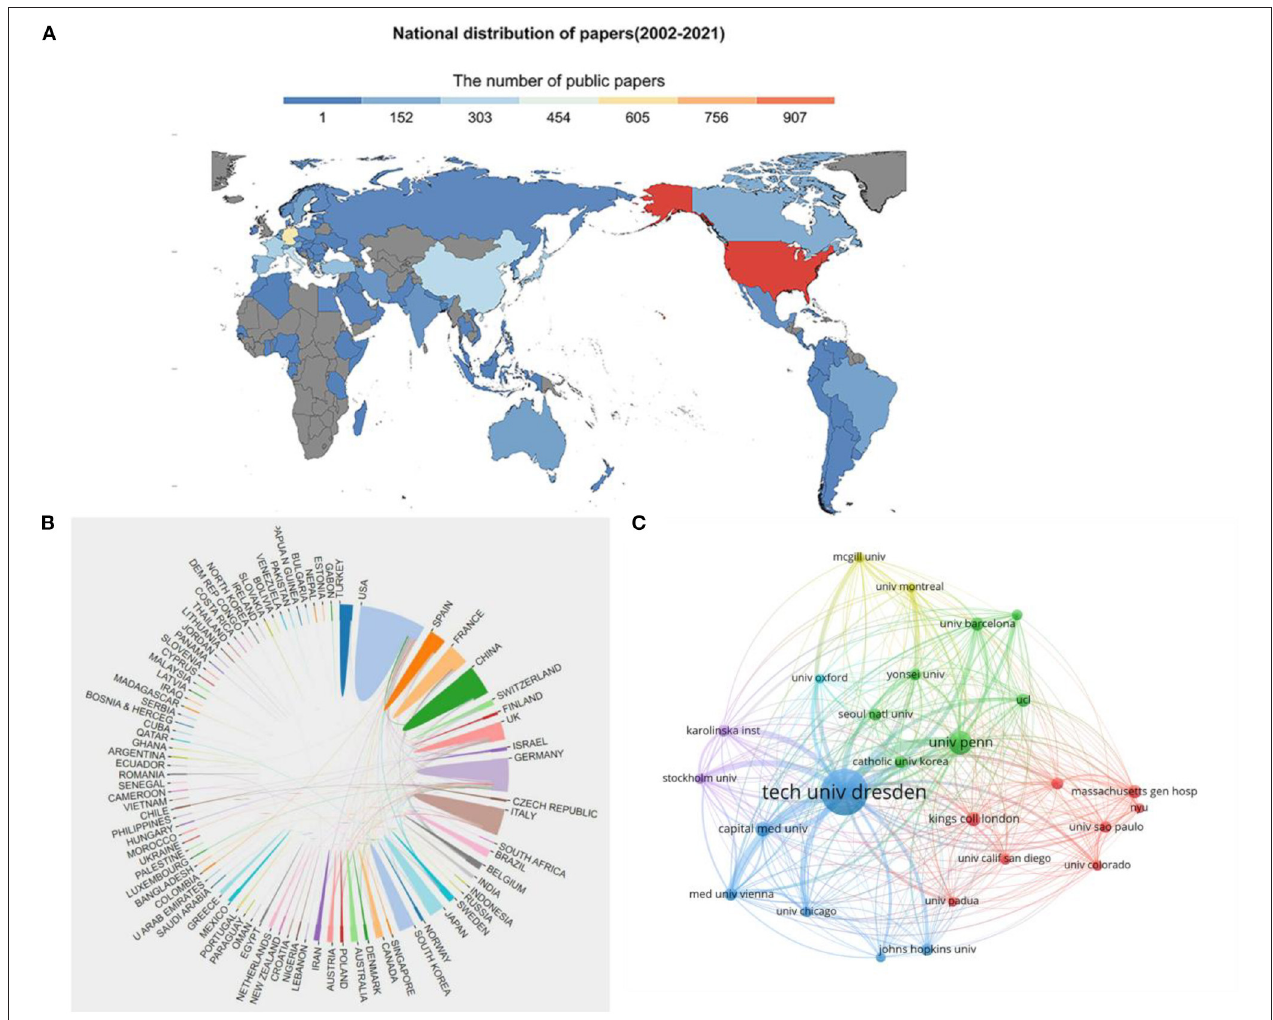
FIGURE 3 | The distribution of countries/regions in terms of publications (A) and the co-operation of countries/regions (B) . A network map showing the institutions involved in research of olfactory dysfunction (C)